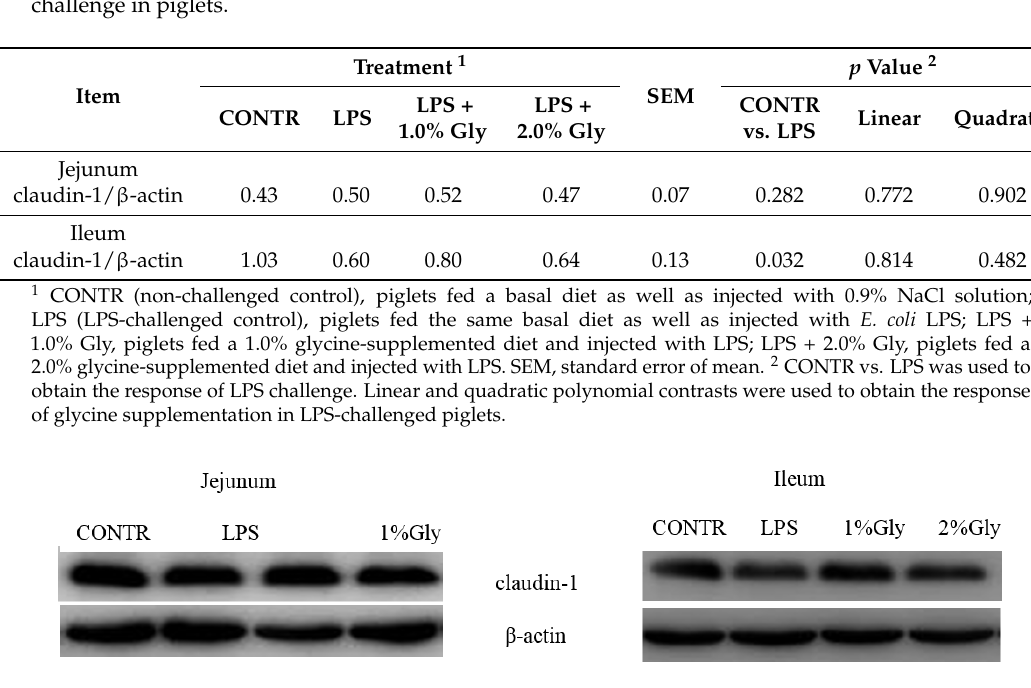
Figure 3. Effects of glycine supplementation on intestinal protein abundance of claudin ‐ 1 after 4 h LPS challenge in piglets.